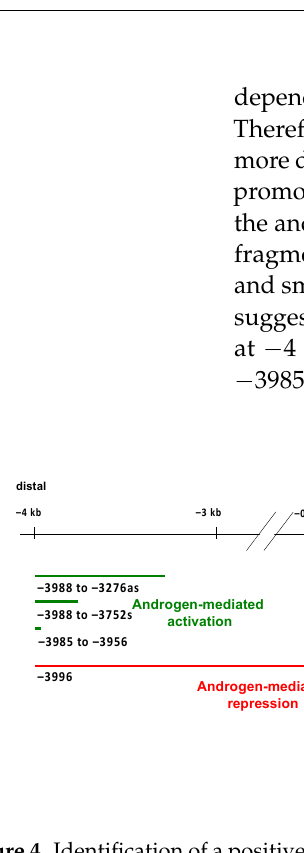
Figure 4. Identification of a positive androgen response element in the hTERT distal promoter. CV1 cells lacking endogenous functional AR and other steroid receptors were co-transfected with AR and pCMV lacZ. The obtained values were normalized to β -galactosidase activity after being co-transfected pCMV-lacZ. e.v.—empty vector; R1881 (10 nM); DHT (10 nM). ( A ) Overview of the hTERT deletion constructs used for the reporter assays. The sections highlighted in green or red color represent the promoter construct activities that mediate an enhanced or repressed reporter activity by androgen treatment, respectively. s—sense; as—antisense. ( B – D ) Luciferase assays with the indicated hTERT promoter regions spanning the − 4 kb to − 1 kb and distal promoter region constructs. * p ≤ 0.05, *** p ≤ 0.001.